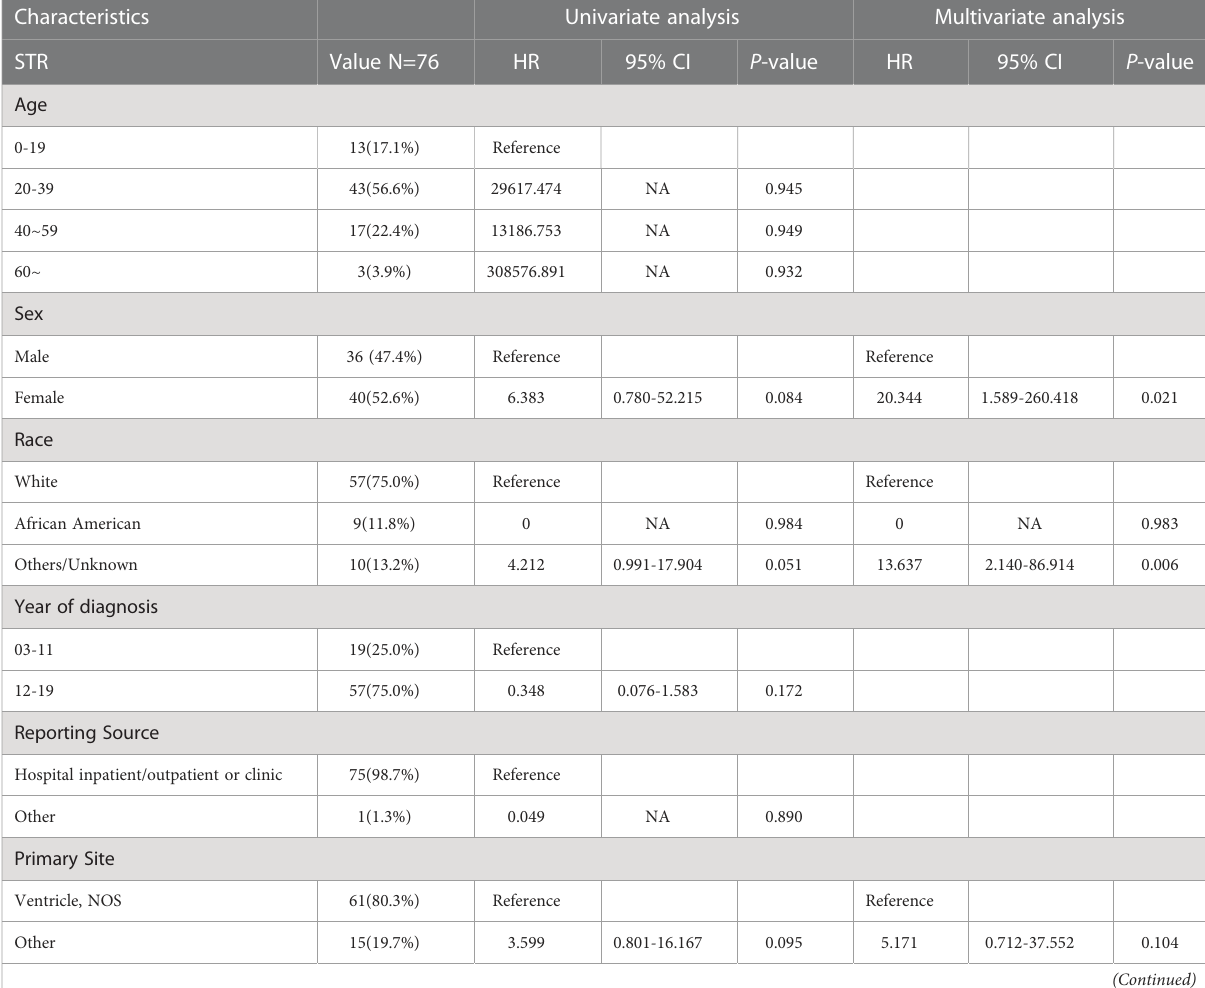
TABLE 3 The median overall survival (OS) of the subtotal resection (STR) was 61.5 (interquartile range (IQR): 33.25 – 80)